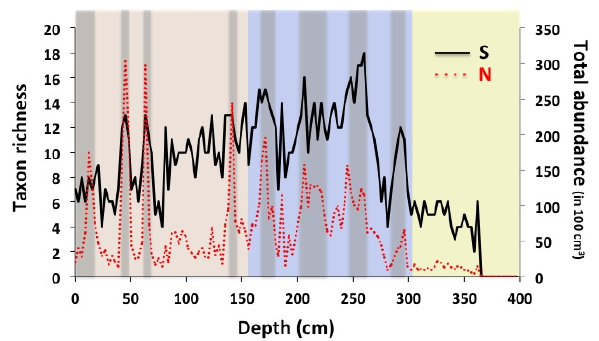
Figure 5. Taxon richness ( S ) and total number of individuals ( N ) with depth from core MM2. Macrofauna samples were taken at fixed volume (100cm 3 ). The different colour bands correspond to depths: azoic (yellow), under higher marine influence (blue), and under a progressive isolation of the Mar Menor from the Mediter- ranean Sea (brown). The grey bands correspond to occasional peaks in species richness, probably related to episodes in which the sand- bar was